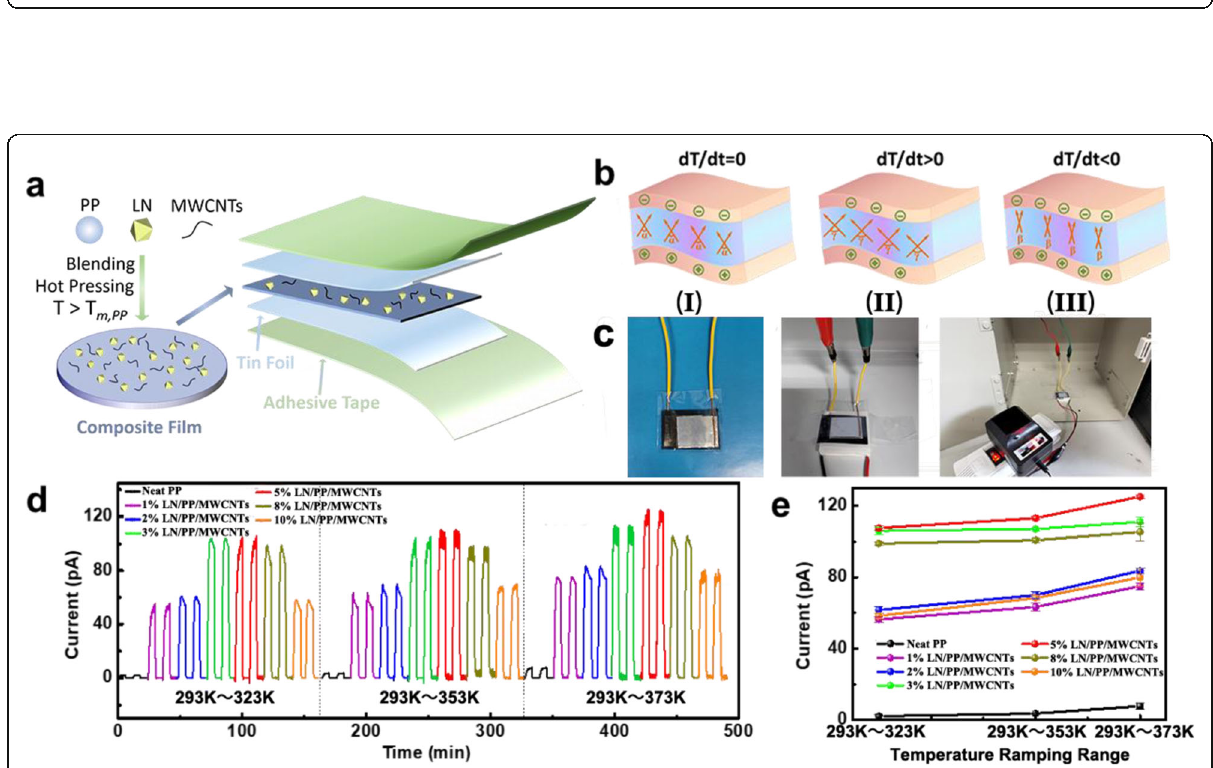
Fig. 4 Pyroelectric effects of LN/PP/MWCNT nanocomposite. a Schematic diagram of the LN/PP/MWCNT composited film fabrication process. b Schematic illustration of the LN/PP/MWCNT pyroelectric nanogenerator structure and working mechanism: (I) the initial polarization state, (II) the heated, and (III) the cooled state of the LN/PP/MWCNT PCF. c Photographs of the heating element working with a DC power supply. d , e Pyroelectric current and trend of the LN/PP/MWCNT composited sensor with temperature ramping dependency and LN microparticles ’ concentration